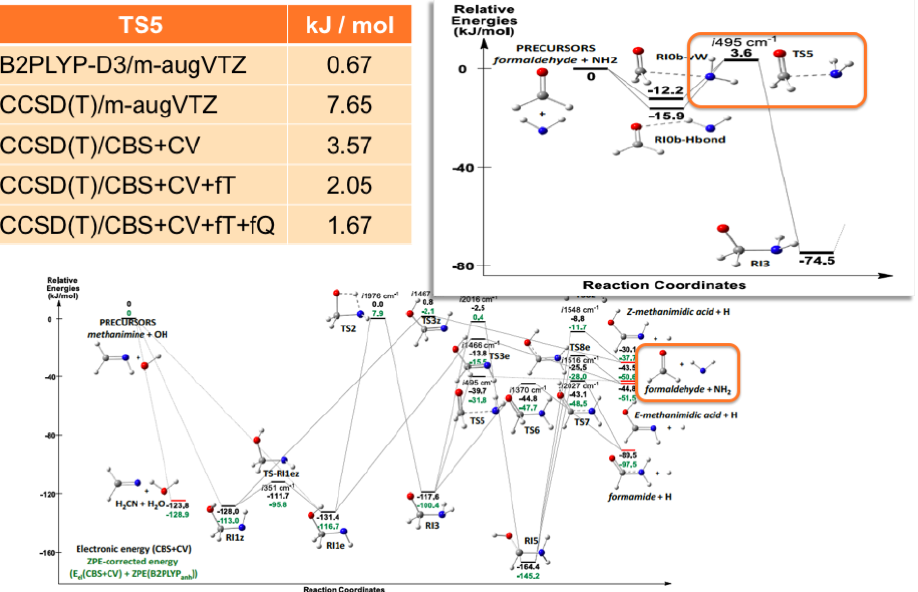
Fig. 4. – Gas-phase formation route of formamide: the impact of the level of theory on reaction